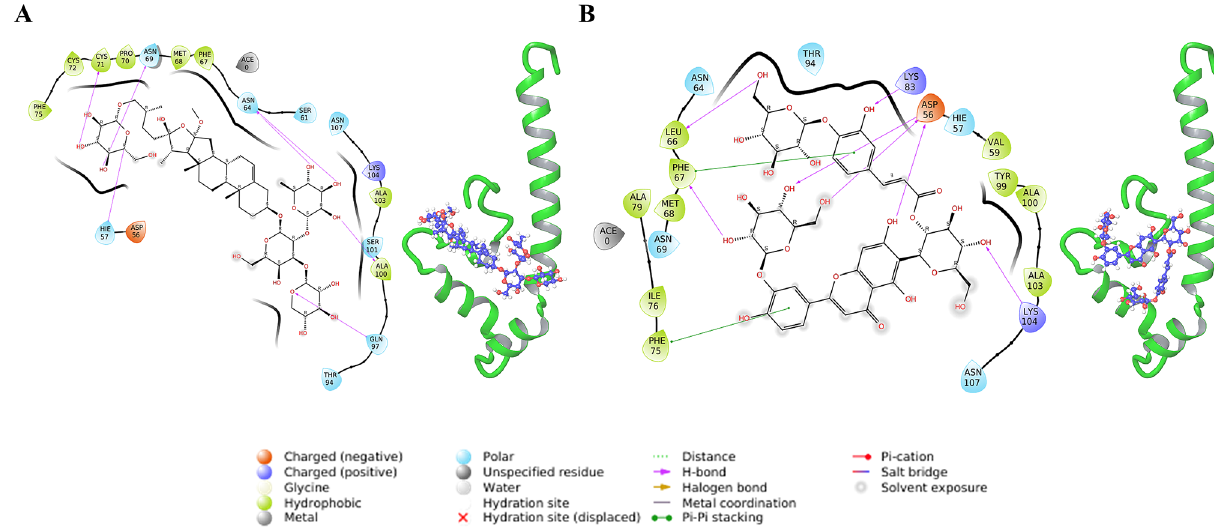
Figure 6. Interactions of natural ligands in XP-pose with IFITM3 ( A ) SN00224572 ( B )